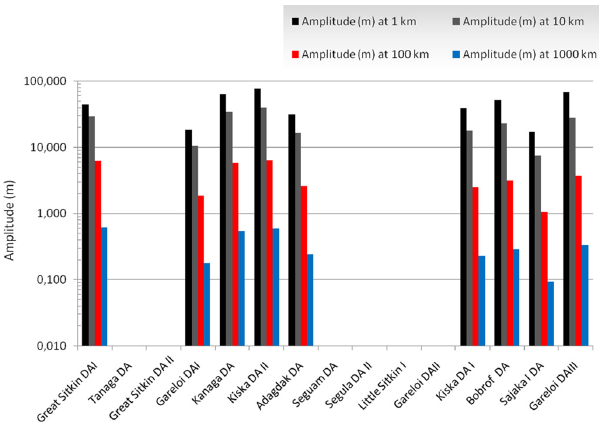
Fig. 14. Histogram showing the estimated amplitude of tsunami wave at fixed distance from the source, for 9 of DAs reported in Table